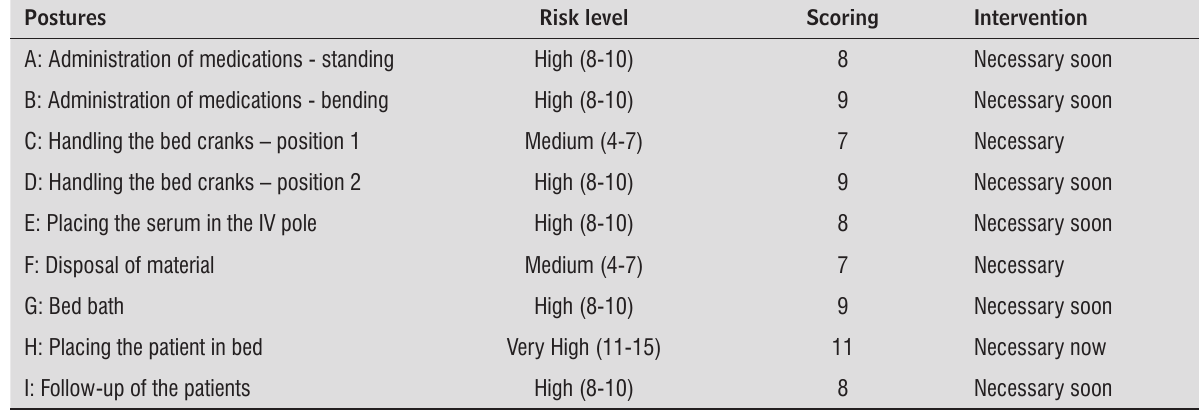
Table 1 - Biomechanical risks of the postures evaluated by the REBA method Postures Risk level Scoring